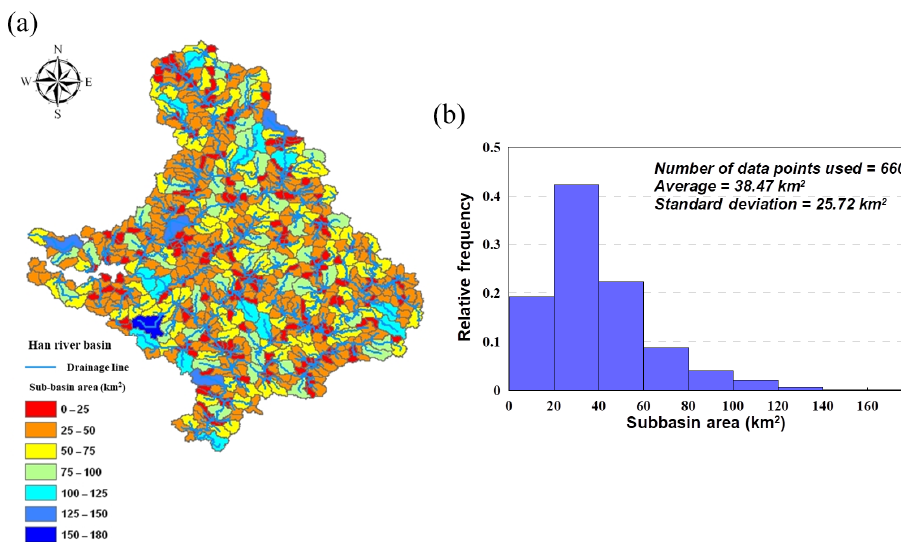
Figure 2. (a) The 660 sub-basins in the Han River basin and (b) the relative frequency of their